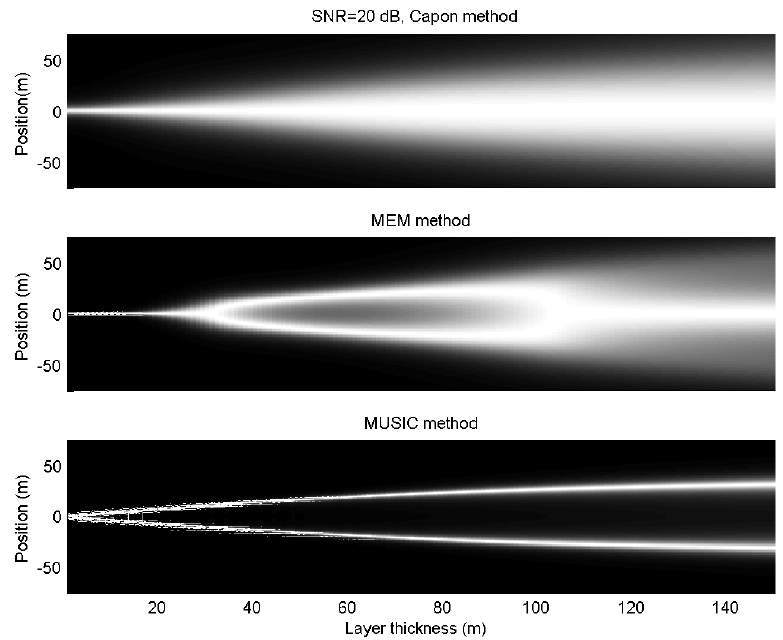
Fig. A3. Results of simulations for the Capon method (top), MEM (center) and MUSIC algorithm (bottom), assuming SNR = 20dB and a single layer of thickness from 0m to